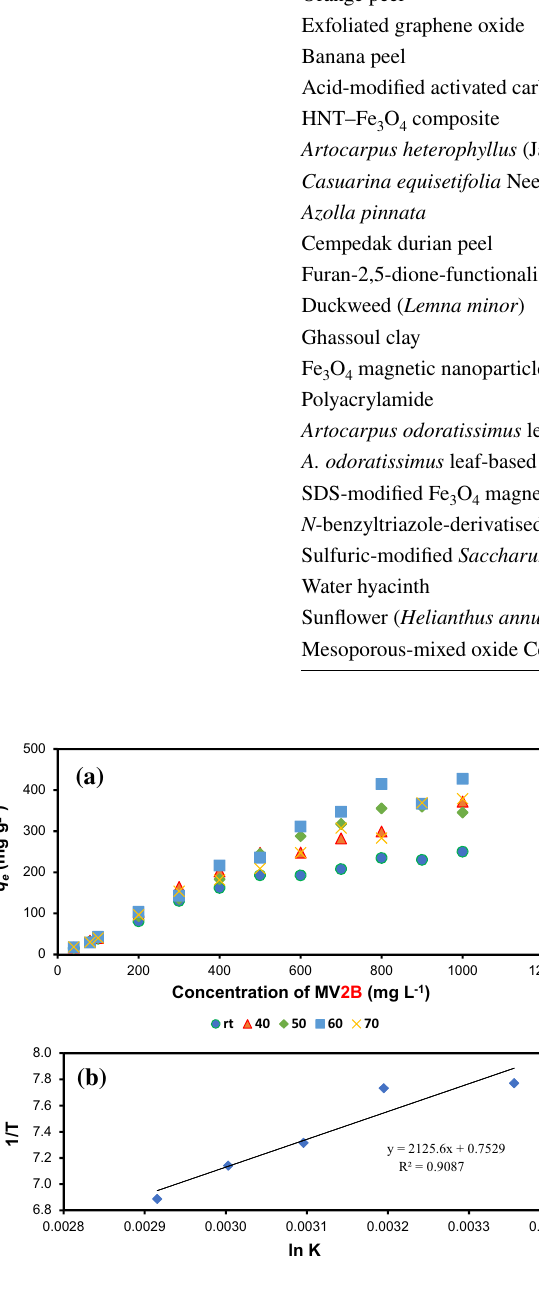
Table 4 Comparison table for the adsorption capacity ( q max ) of different adsorbents for the removal of MV2B